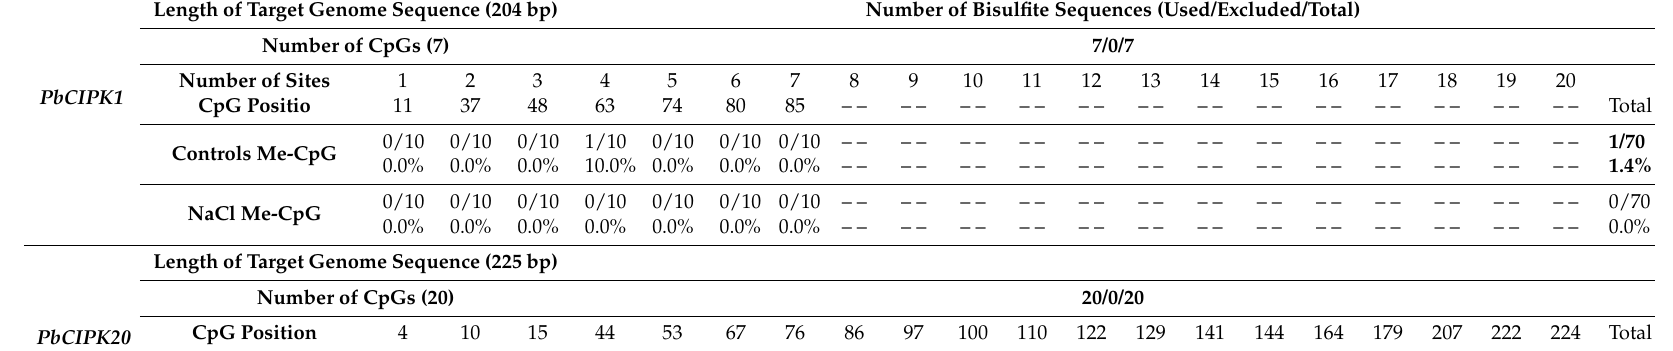
Table 2. Methylation analysis of a 200 bp promoter segment in PbCIPK1 , PbCIPK20 , and PbCIPK22 in P. betulaefolia under salt stress treatment.